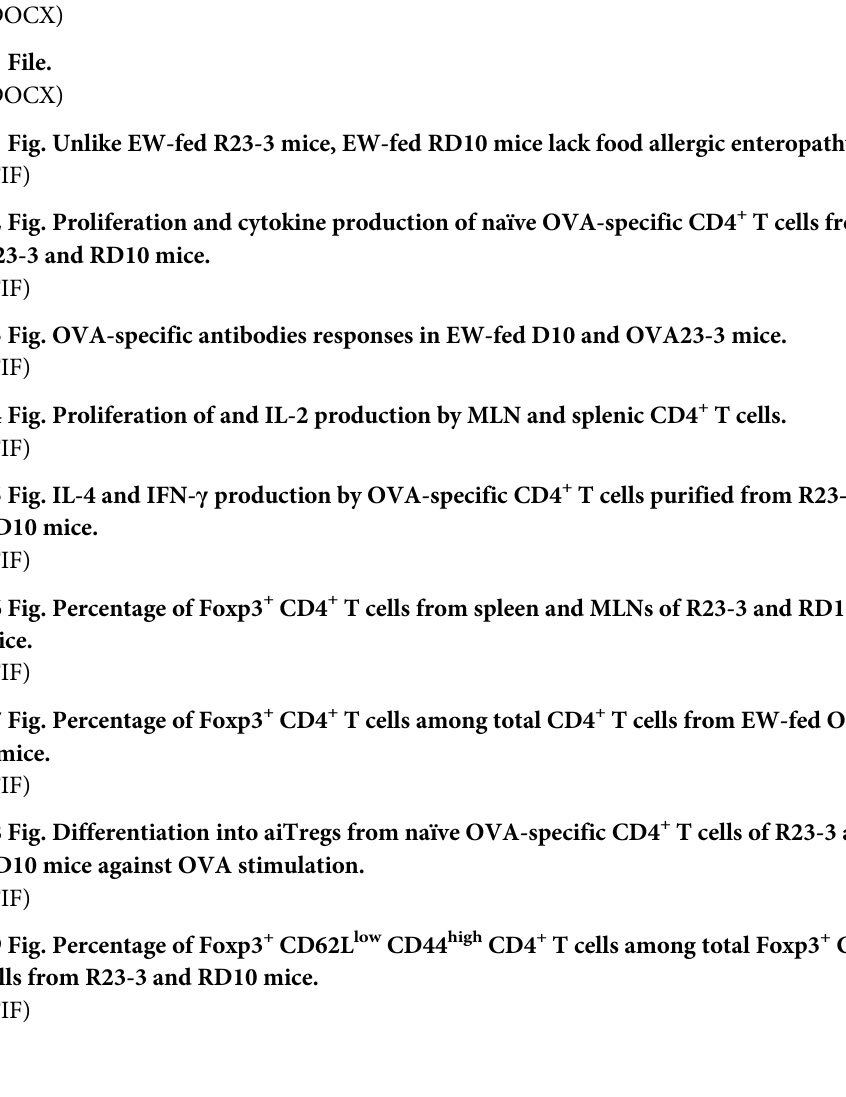
S2 Fig. Proliferation and cytokine production of naïve OVA-specific CD4 + T cells from R23-3 and RD10 mice. S3 Fig. OVA-specific antibodies responses in EW-fed D10 and OVA23-3 mice. S4 Fig. Proliferation of and IL-2 production by MLN and splenic CD4 + T cells. S5 Fig. IL-4 and IFN- γ production by OVA-specific CD4 + T cells purified from R23-3 and RD10 mice. S6 Fig. Percentage of Foxp3 + CD4 + T cells from spleen and MLNs of R23-3 and RD10 mice. S7 Fig. Percentage of Foxp3 + CD4 + T cells among total CD4 + T cells from EW-fed OVA23- 3 mice. S8 Fig. Differentiation into aiTregs from naïve OVA-specific CD4 + T cells of R23-3 and RD10 mice against OVA stimulation. S9 Fig. Percentage of Foxp3 + CD62L low CD44 high CD4 + T cells among total Foxp3 + CD4 + T cells from R23-3 and RD10